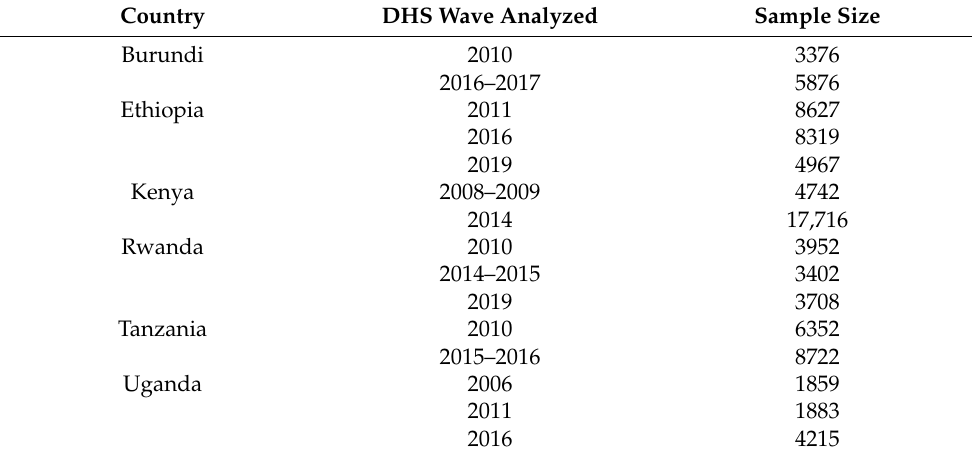
Table 1. Demographic Health Survey waves for each country included in the study. Country DHS Wave Analyzed Sample Size